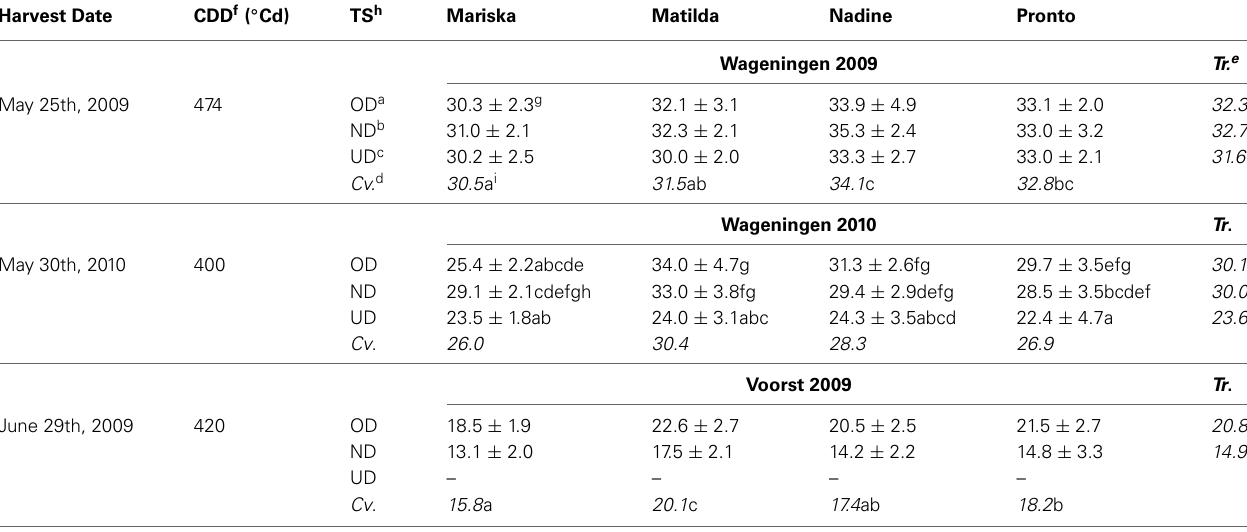
Table 3 | Average shoot dry weights (g per plant) of the four cultivars at final harvest, after establishment from three different transplant sizes in each of three trials.